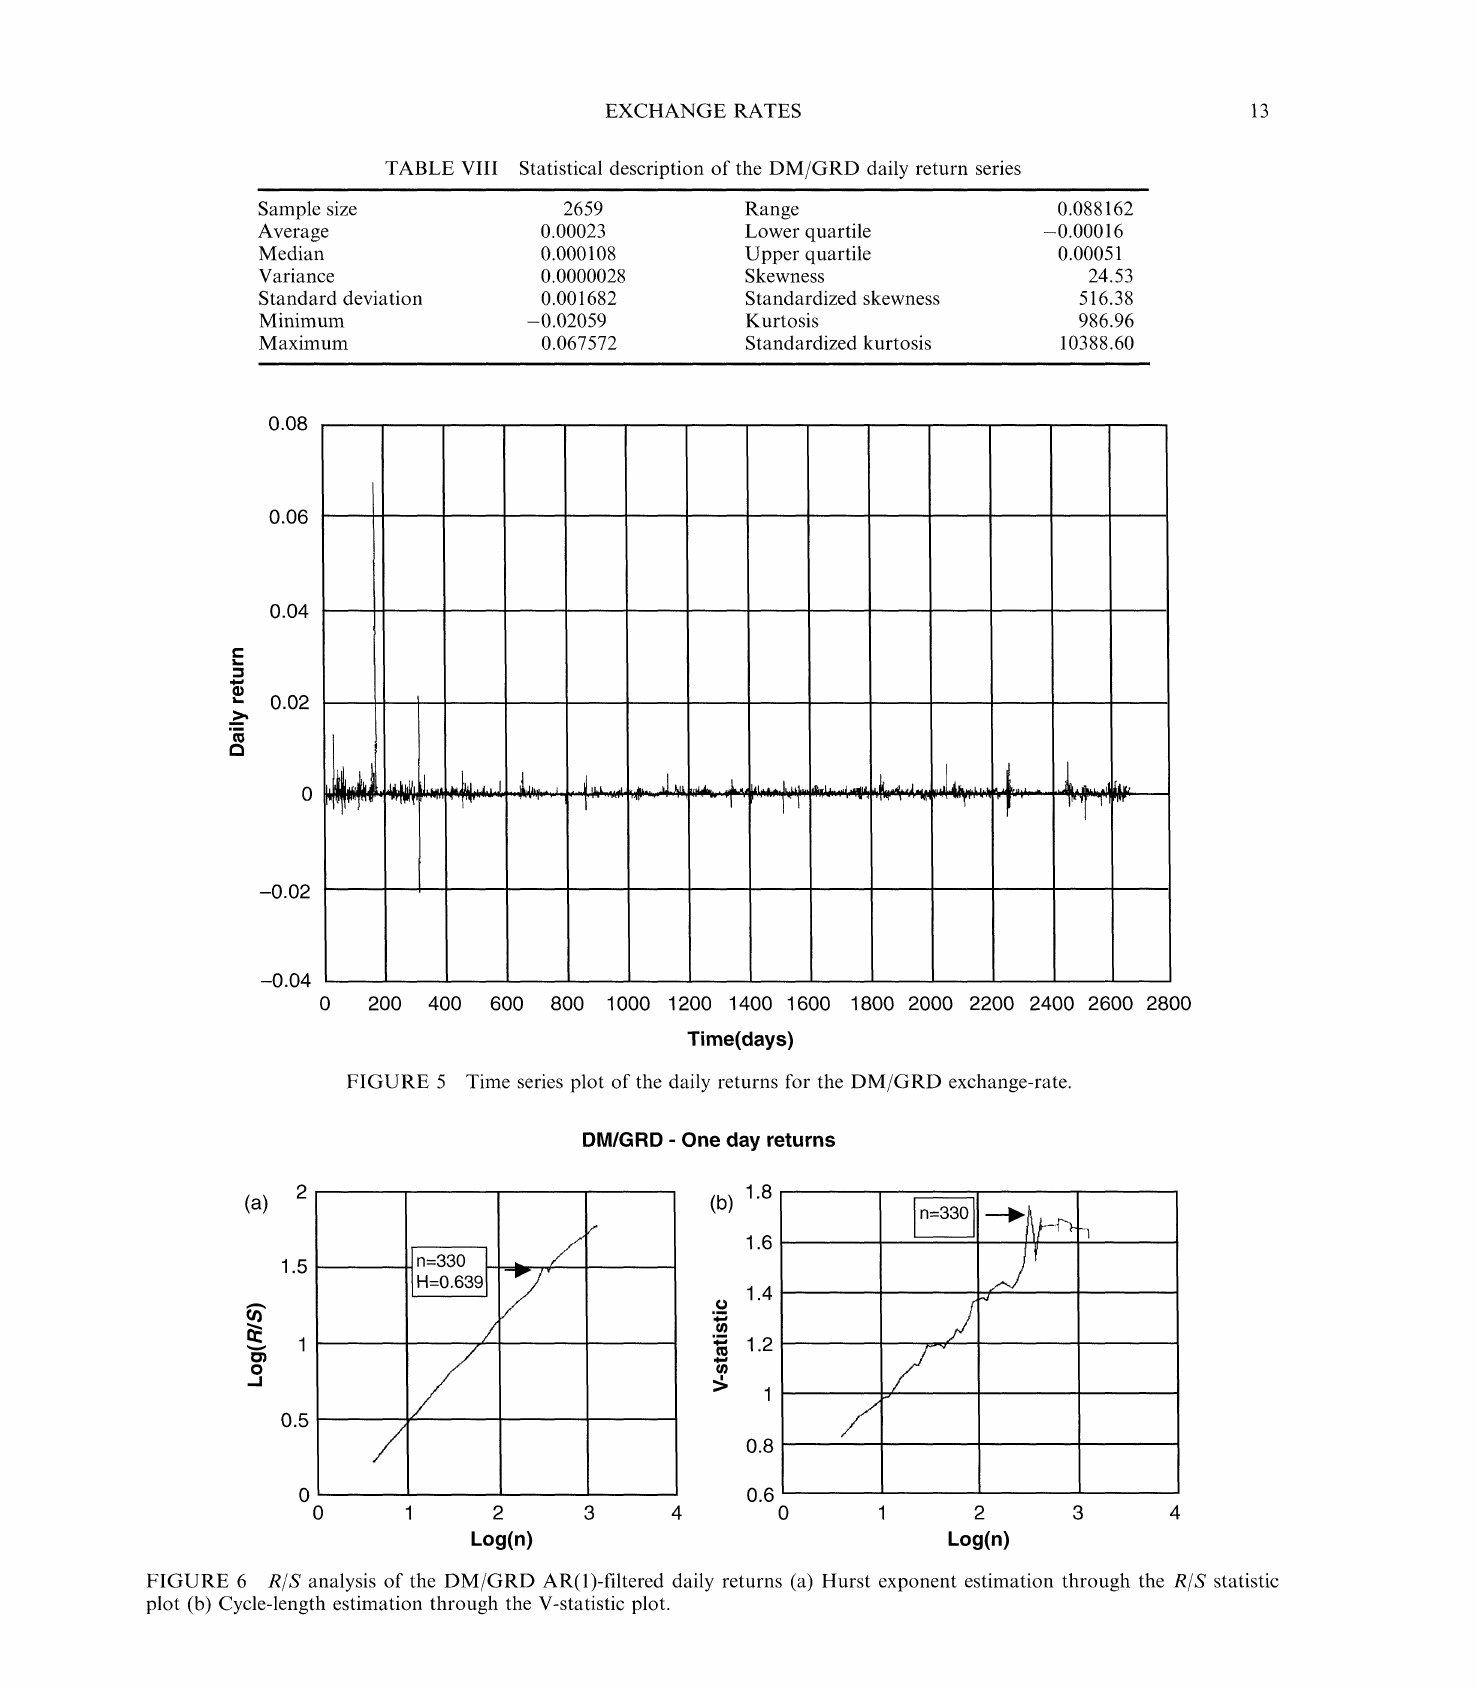
TABLE VIII Statistical description of the DM/GRD daily return series